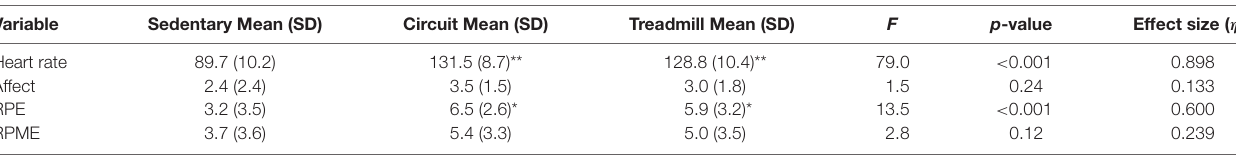
TABLE 3 | Manipulation checks by